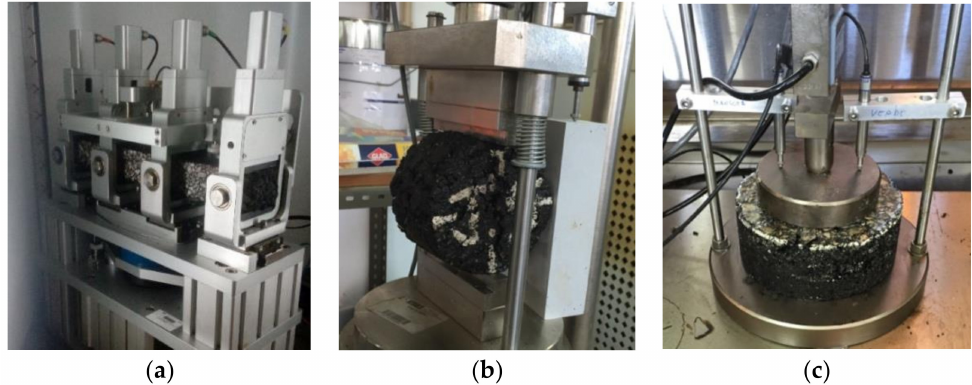
Figure 5. Mechanical performance tests: ( a ) four-point bending test; ( b ) indirect tensile strength test; and ( c ) cyclic compression